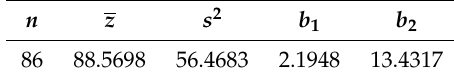
Table 3. Summary statistics for Rubidium